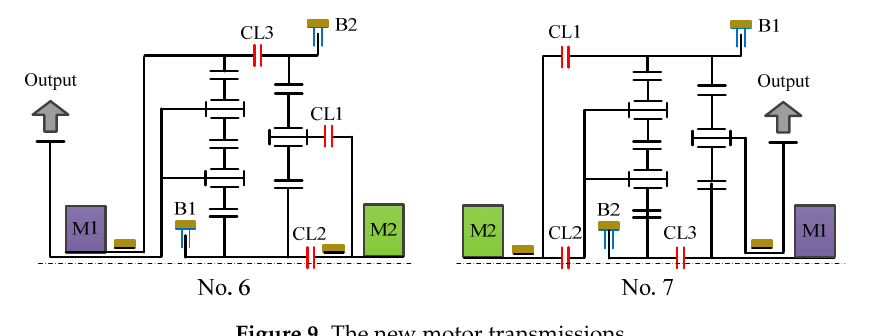
Figure 9. The new motor transmissions.